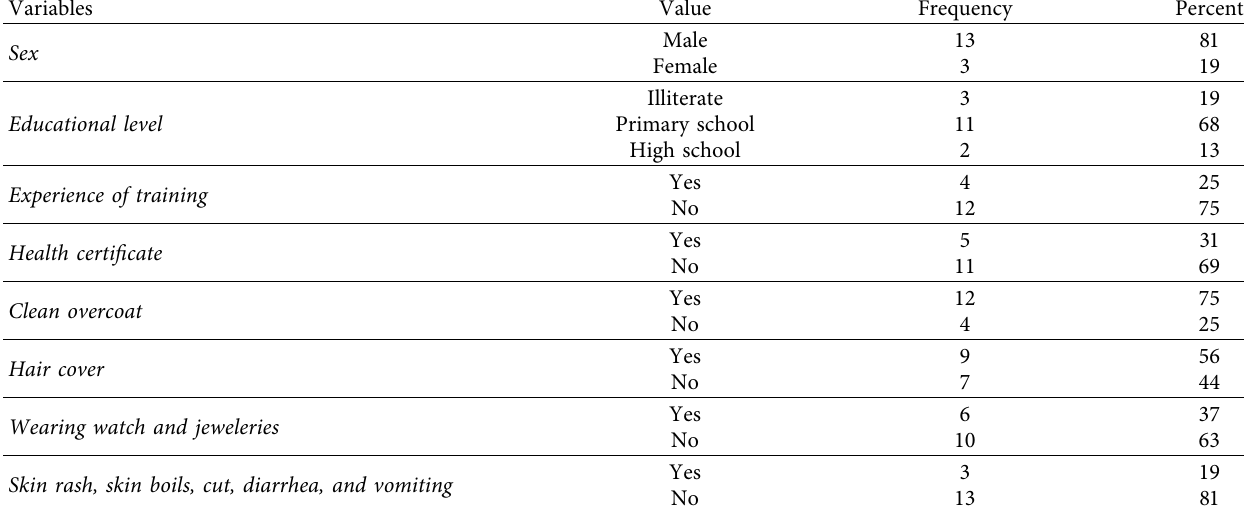
Table 1: Survey on knowledge of butchers on hygienic practices in Debre Berhan town.